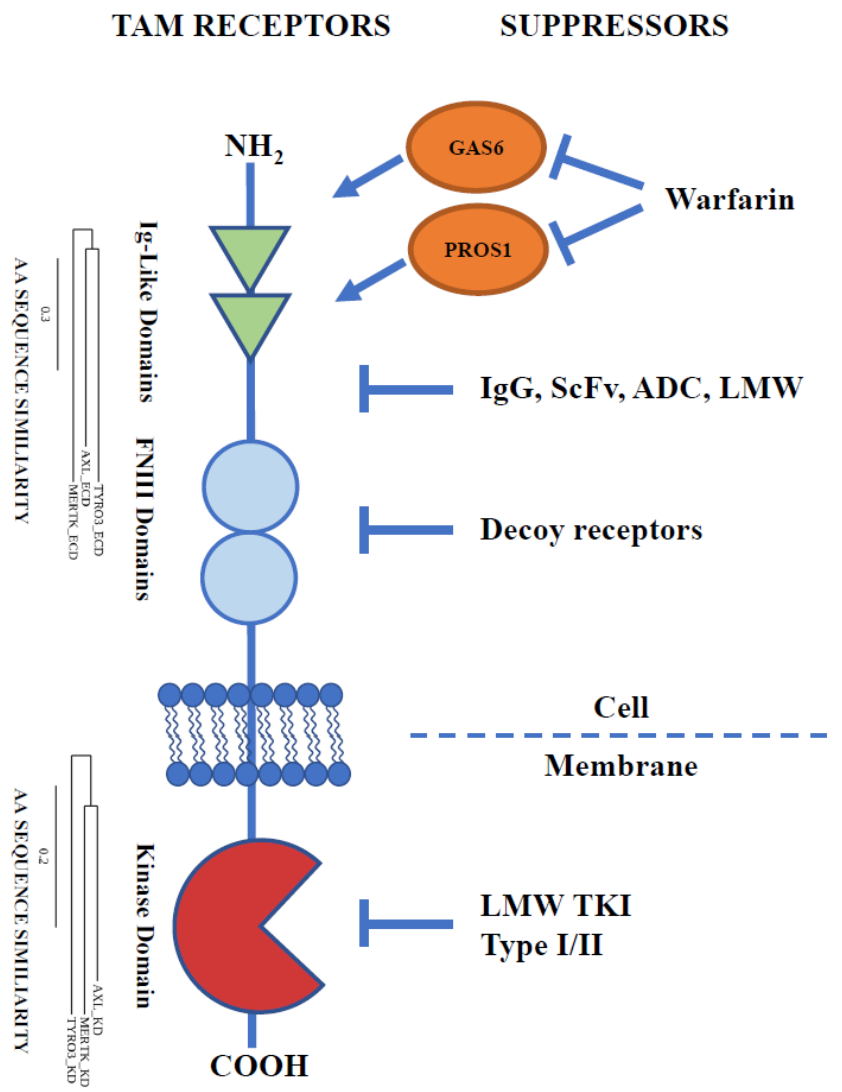
Figure 1. Different strategies of inhibition of TAM receptor activity. Abbreviations: GAS6, Growth arrest-specific 6 ligand; PROS1, Protein S; IgG, immunoglobulin G antibodies; scFv, single-chain variable fragment antibodies; ADC, antibody–drug conjugates; LMW, low-molecular-weight compounds; TKI, tyrosine kinase inhibitors; IgG-like domains, immunoglobulin-like domains; FNIII domains, fibronectin type III domains; AA, amino acid; ECD, extracellular domain; KD, kinase domain.